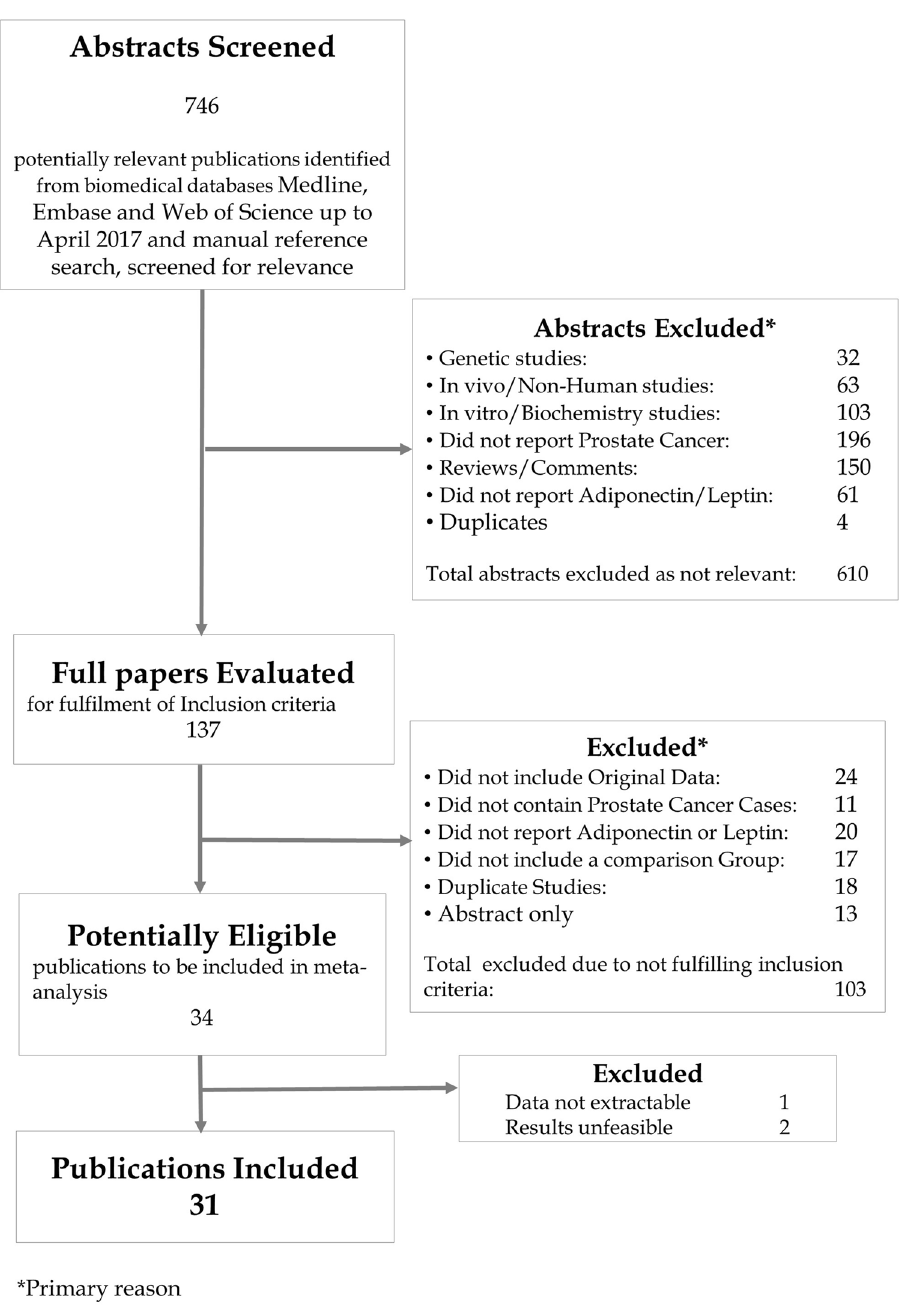
Figure 1. Flow diagram of study